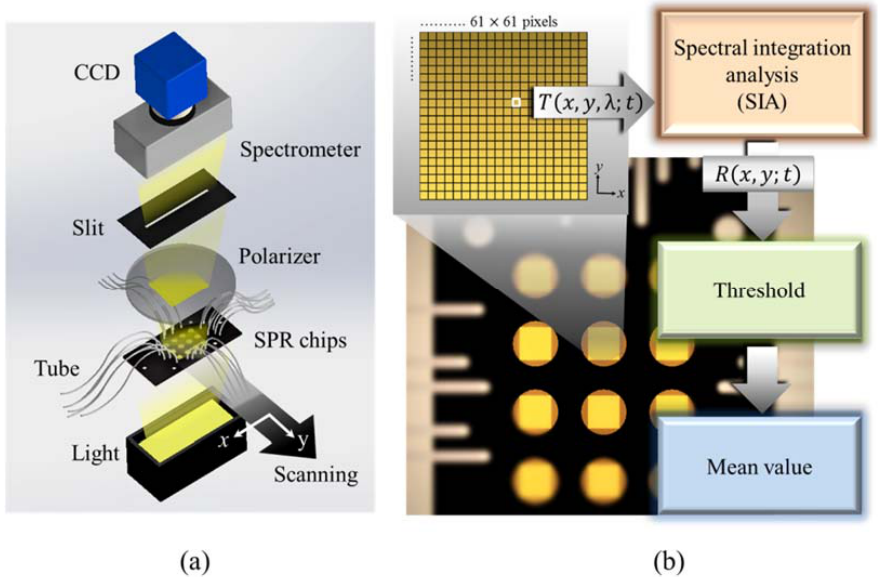
Figure 2. ( a ) The spectral SPR scanning system for capturing multiple SPR spectral images from a 12-well SPR fluidic chip. ( b ) The effective detection area contained 61 × 61 pixels. The transmission spectra of each pixel were recorded for further analysis based on the SIA.